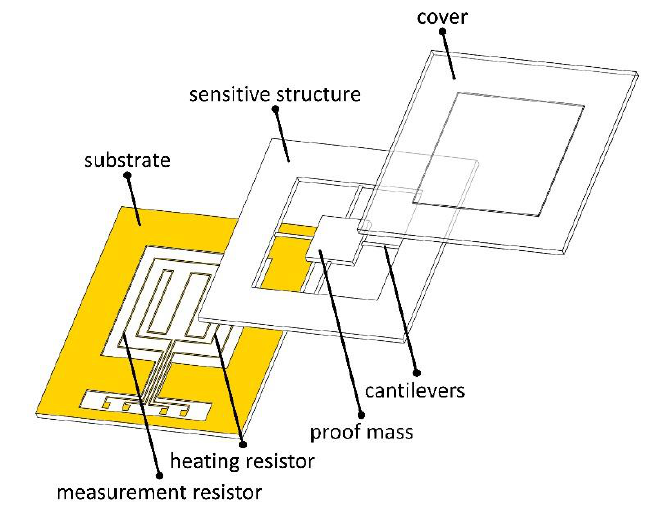
Figure 1. Controlled hardware object.